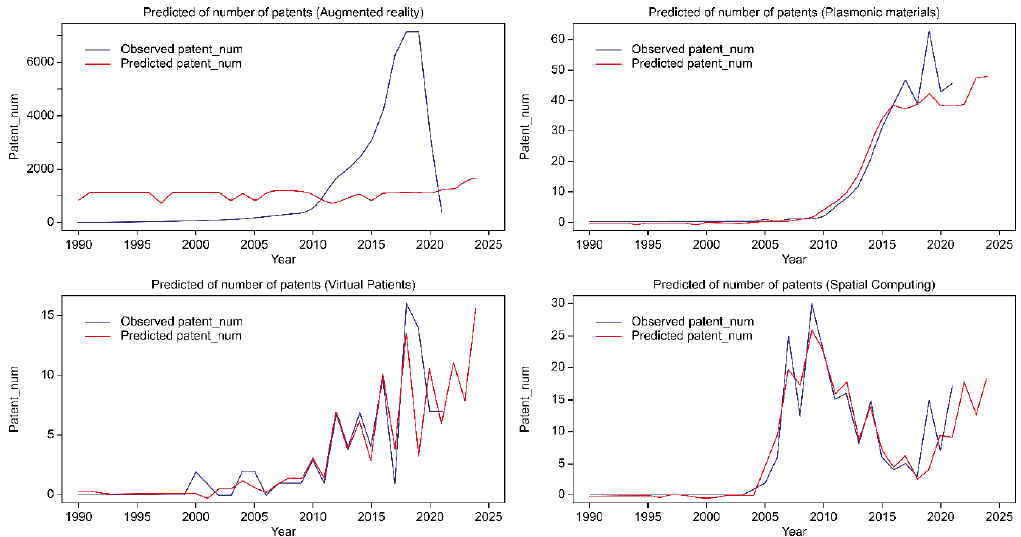
Figure 3. Number of patents in the input data and the predicted number of patents by year for the technologies predicted as the future promising technologies.